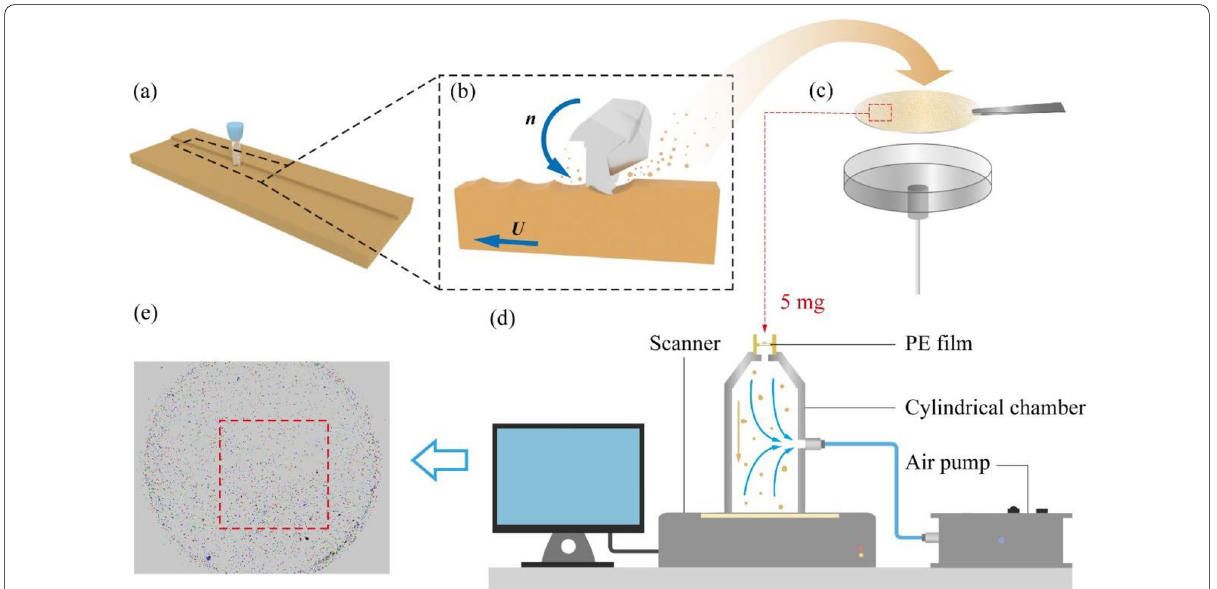
Fig. 1 Flowchart of dust sampling and scanning. a Diagram of MDF milling; b up-milling; c an acrylic disc held by a round dish was used to collect the falling dust in MDF milling at each sampling point; d flatbed scanning image analysis devices; e dust